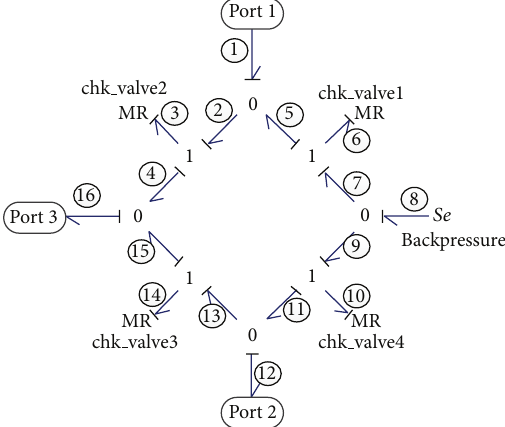
Figure 7: Bond graph model of the rectifier valve.